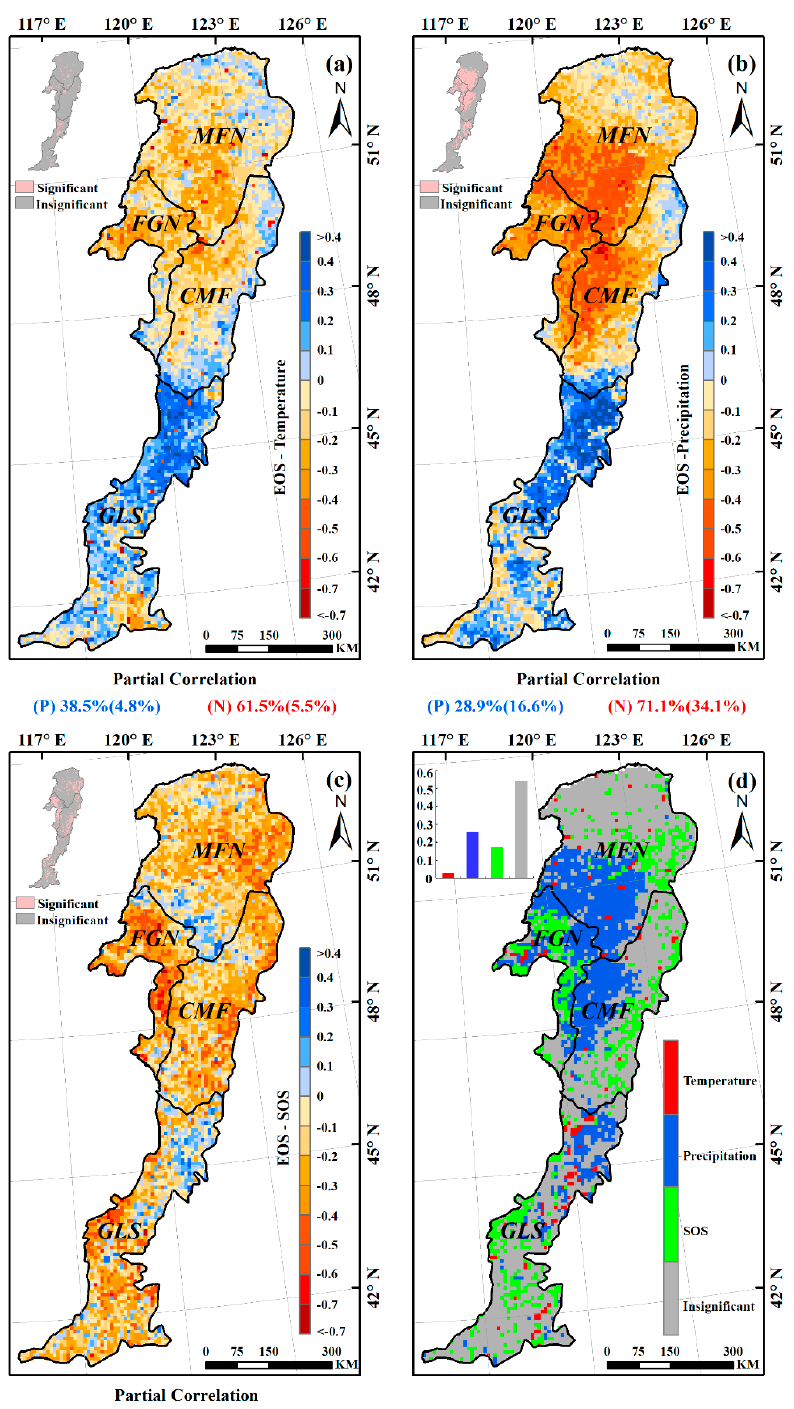
Figure 8. Spatial distribution of partial correlation coefficients between EOS and preseason temperature ( a ); preseason precipitation ( b ); SOS ( c ) in the Greater Khingan Mountains during 1982–2015. The pink pixels in the top-left inset indicate a significant correlations at p < 0.05. ( d ) The spatial distribution of major controls on the EOS over the Greater Khingan Mountains during 1982–2015. The grey pixels indicated none of the three factors was significantly ( p < 0.05 level) correlated with EOS.